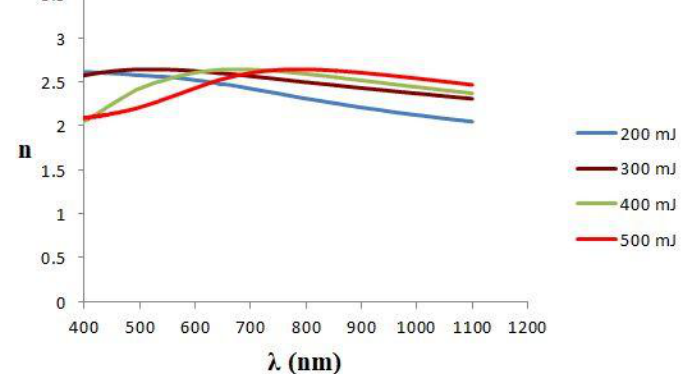
Fig. 8: Refractive index (n) of PbS nanostructure deposited at different laser energies as a function of the wavelength.